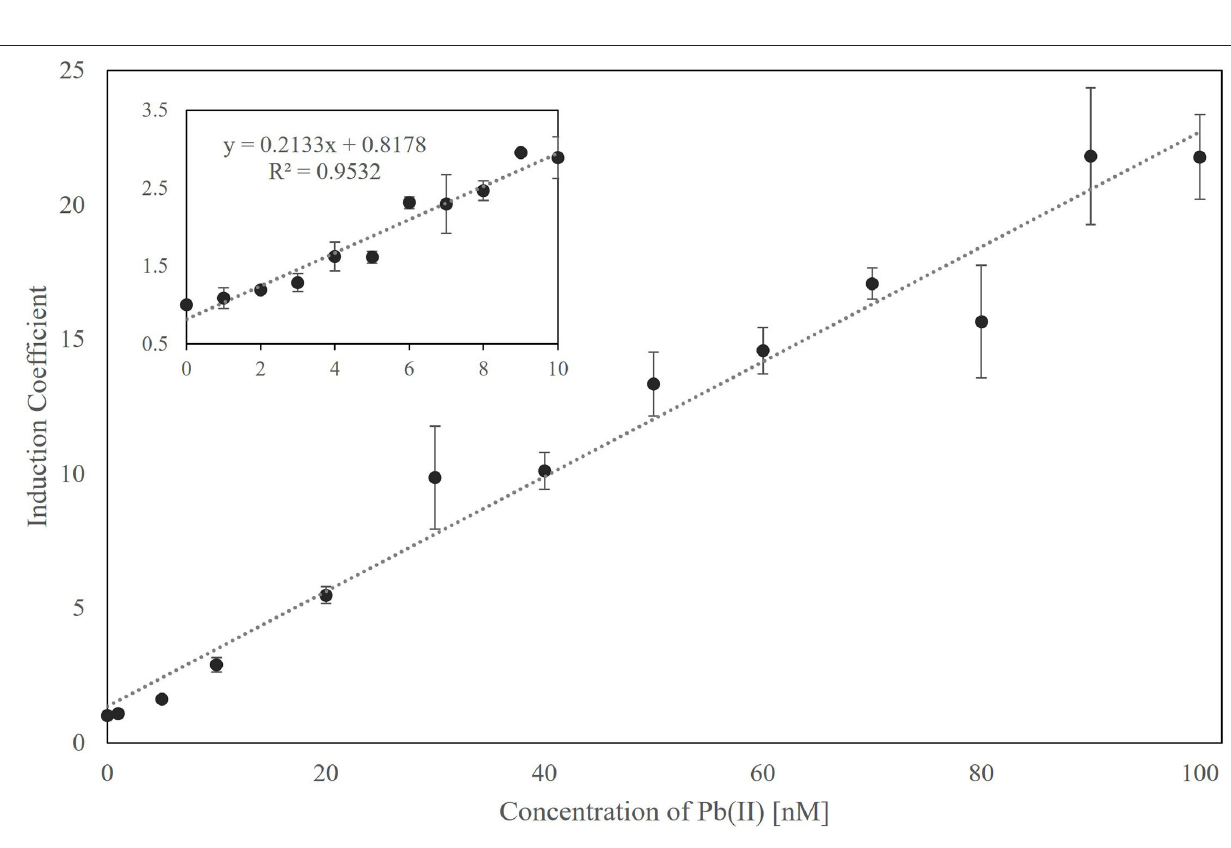
Frontiers in Microbiology |